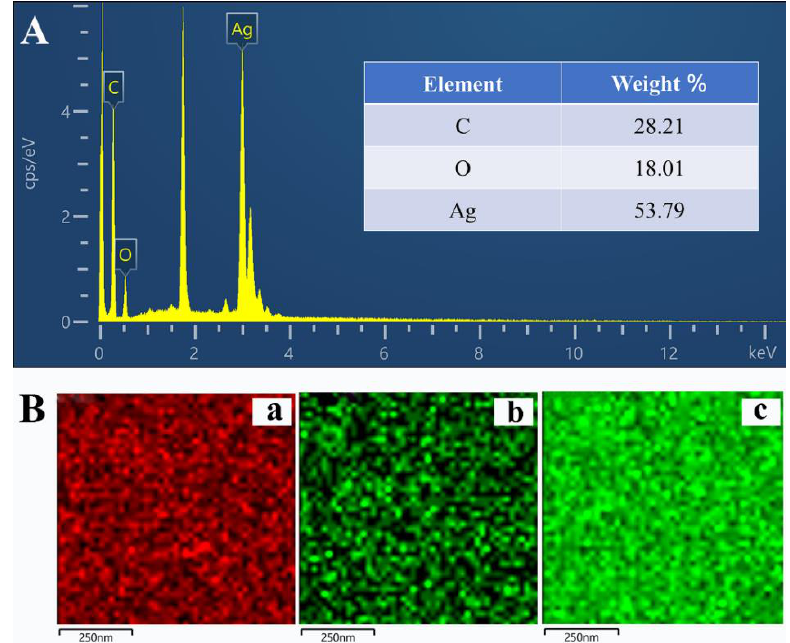
Figure 2. The EDS elemental analysis ( A ) of Ag-TPA CPNs. Inset: The element contents of C, O and Ag, and the corresponding elemental maps ( B ) of C ( a ), O ( b ), and Ag ( c ).